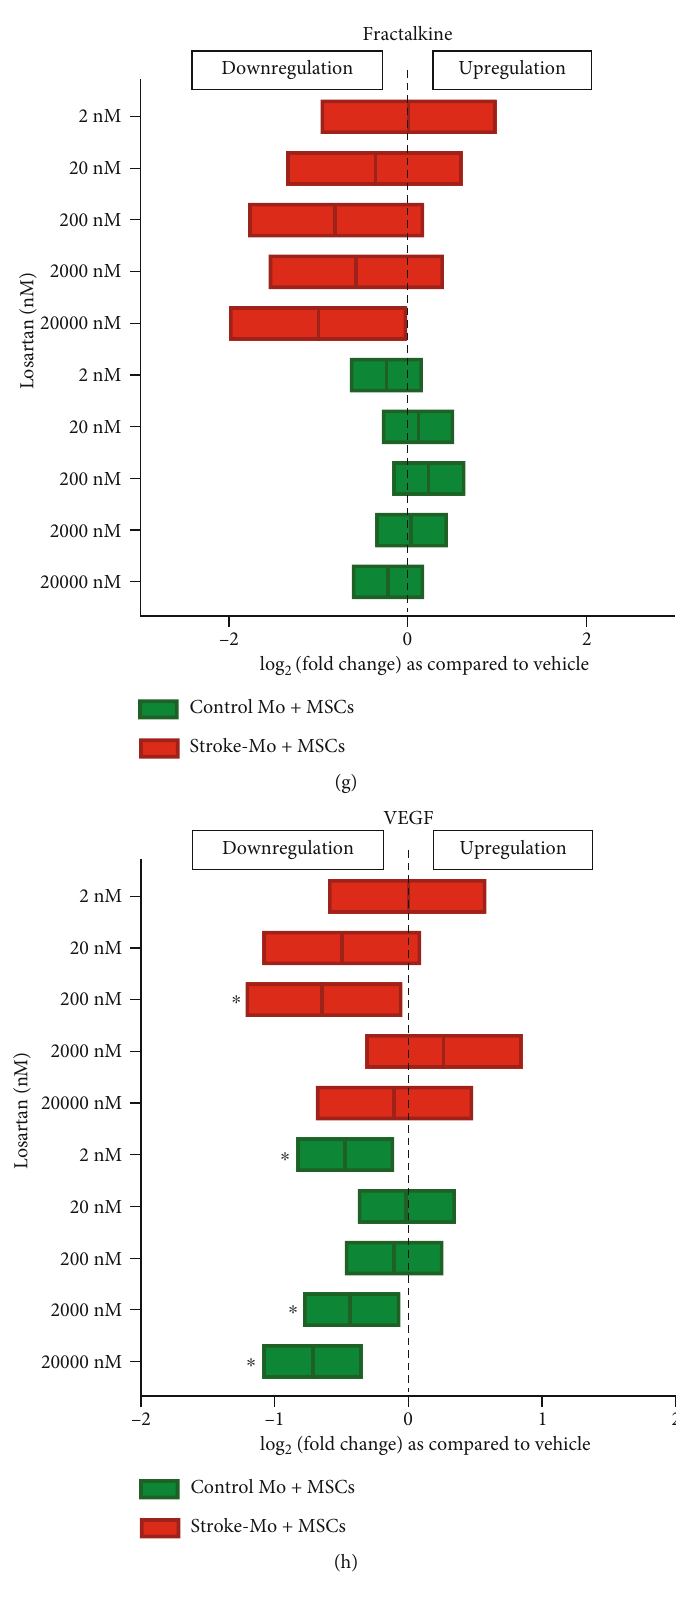
Figure 5: Losartan reduces the cytokine secretions of IL-1 β , IL-8, MCP-1, TNF- α , IL-1RA, IL-6, and VEGF from cocultures of healthy control monocytes with MSCs after 24 hours of exposure, while decreasing only IL-8 secretions from cocultures involving stoke patient-derived monocytes without changing any other cytokine secretions. Signi fi cance is shown by ∗ p < 0 : 05 . All fold changes are as compared to vehicle